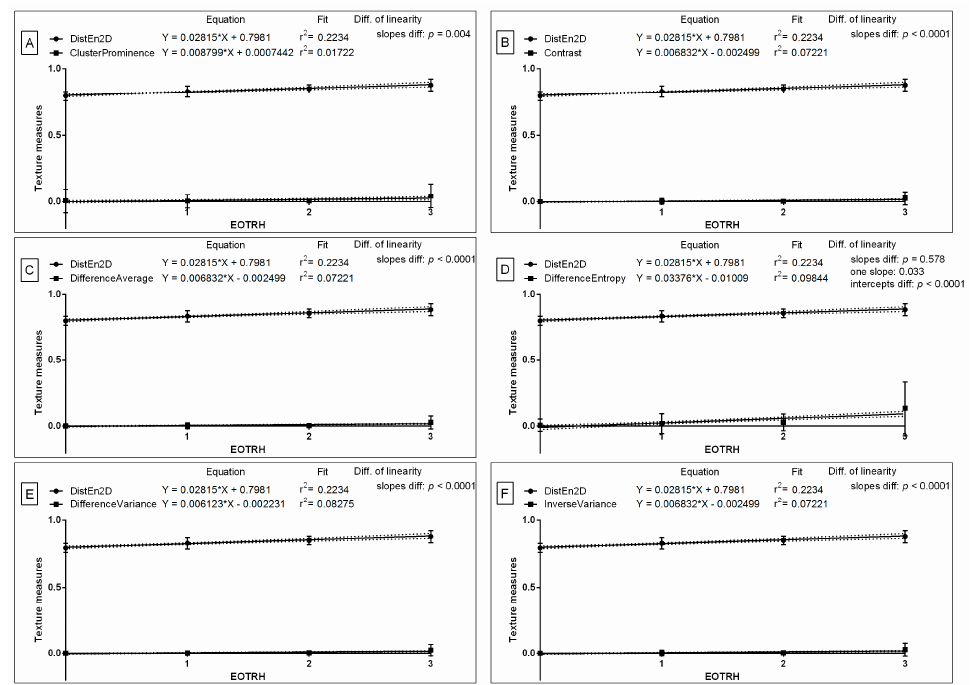
Figure 6. Comparison of selected entropy measure (DistEn2D–two–dimensional distribution entropy) and selected Gray–Level Co–occurrence Matrix (GLCM) features (Cluster Prominence ( A ), Contrast ( B ), Difference Average ( C ), Difference Entropy ( D ), Difference Variance ( E ), Inverse Variance ( F )) throughout the EOTRH grades. Measure and features were extracted from the output radiographs after Normalize filtering. Similarity was tested using linear regressions. A p < 0.05 was considered significant. If the difference between slopes was not significant, a single slope measurement was calculated. Plot where the slope value of the entropy measure was higher than the slope value of the GLCM features was marked by dashed frames.